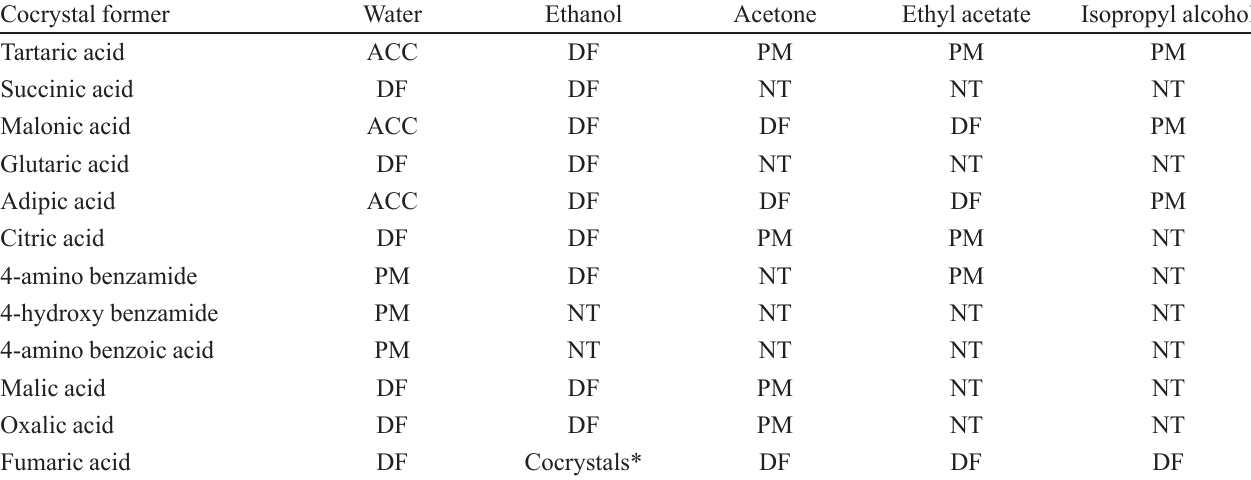
TABLE III - Screening of cocrystal formation using different solvents Cocrystal